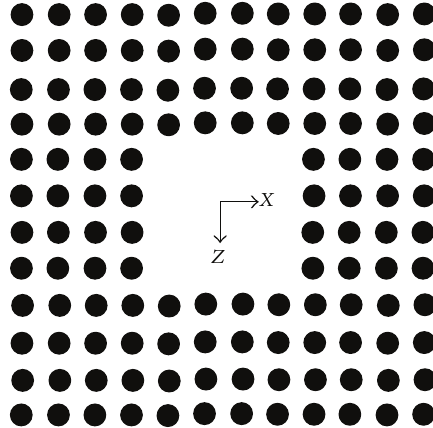
Figure 2: The 4 × 4 resonant cavity model of the two-dimensional PBGS made by GaAs pillars in air with square